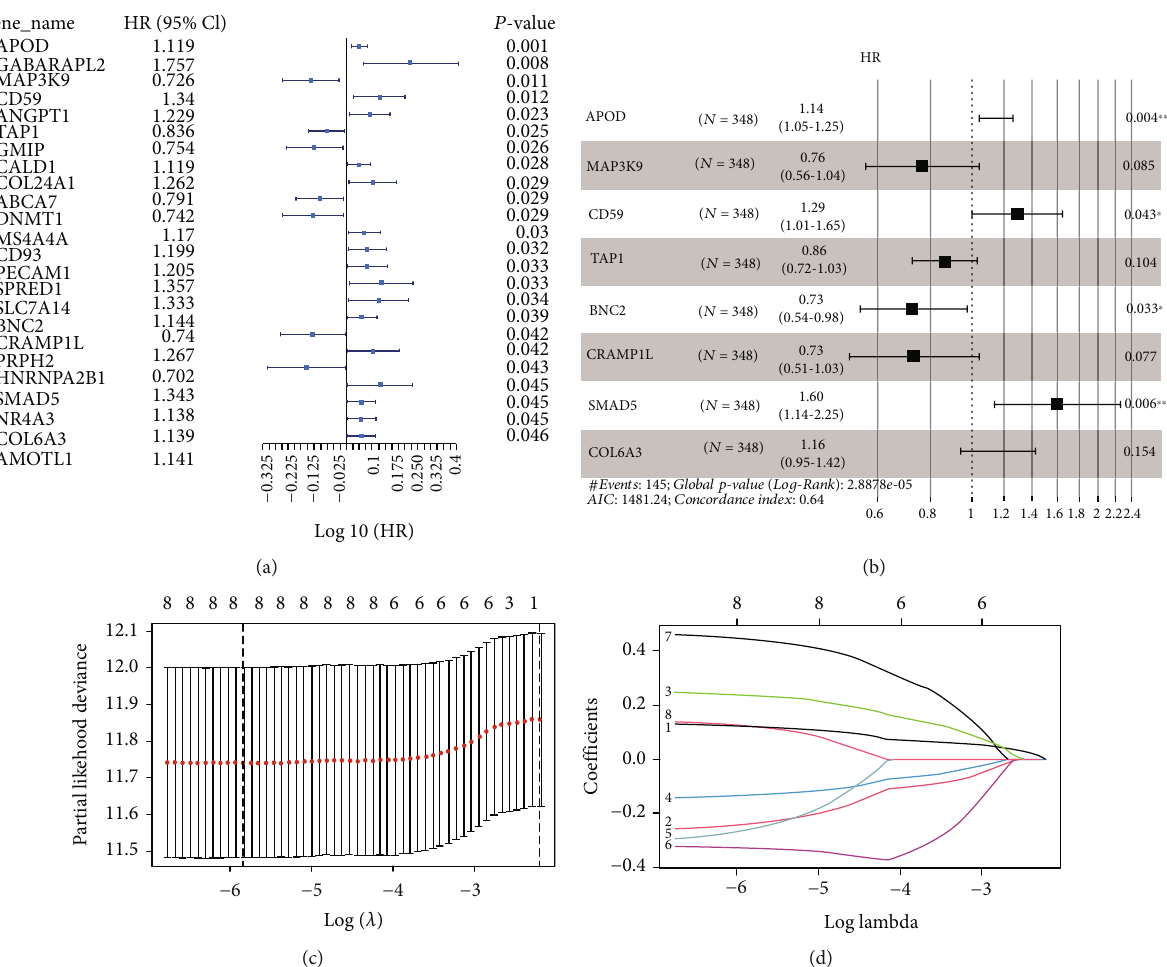
Figure 3: Construction of the prognostic model. (a) Univariate Cox analysis. (b). Multivariate Cox analysis. (c, d) The Lasso regression and tenfold cross-validation. Finally, a risk scoring formula composed of 8 genes was obtained. Therisk value = APOD × 0 : 125 + MAP3K9 × 0 : 245 + CD59 × 0 : 240 + TAP1 × Þ